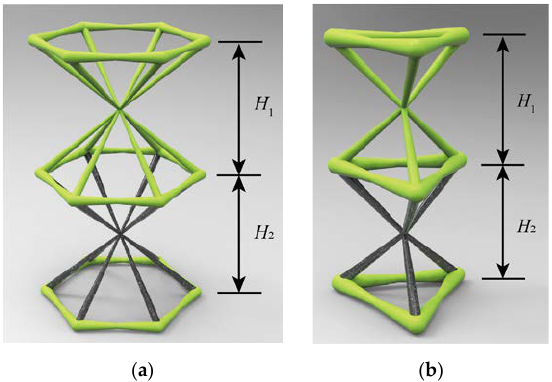
Figure 3. Schematic illustration of the dual-layer unit cell ( a ) hexagon type; ( b ) triangle type.